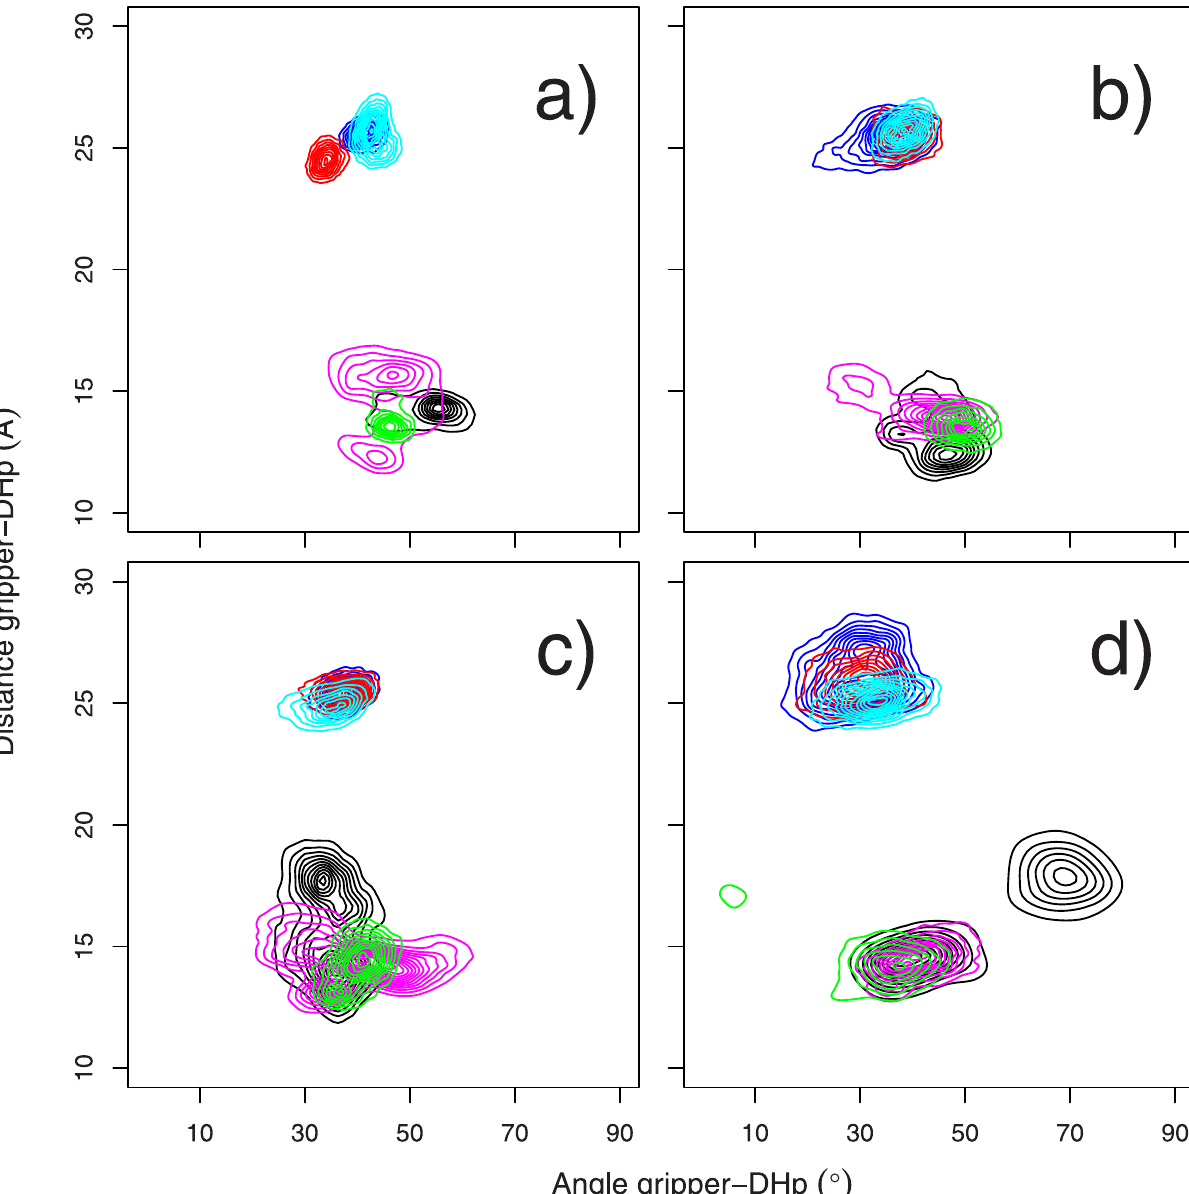
Fig 5. Analysis of the CpxA enzymatic state. C α -C α distances ( Å ) between N360 of region CA and H248 of region DHp plotted along the angles (˚) between a gripper helix and its companion DHP helix ie: the gripper helix of CA � with helix 1A and the gripper helix of CA − with helix 1B (Fig 1). The gripper helices are defined from residue G420 to Q430 in CA � and CA − and the companion DHp α helices are defined from residue M235 to T255. Plots are given for the trajectories MD (a) and TAMD: dbl15 (b), mid15 (c) and tet20 (d), and on each plot the contours are colored according to the replicate. The distance between N360 of chain A (CA − ) and H248 of chain B is plotted along the angle between the gripper helix of CA − and the helix 1B of DHp using colors blue/red/cyan, whereas the distance between N360 of chain B (CA � ) and H248 of chain A is plotted along the angle between the gripper helix of CA � and the helix 1A of DHp using colors